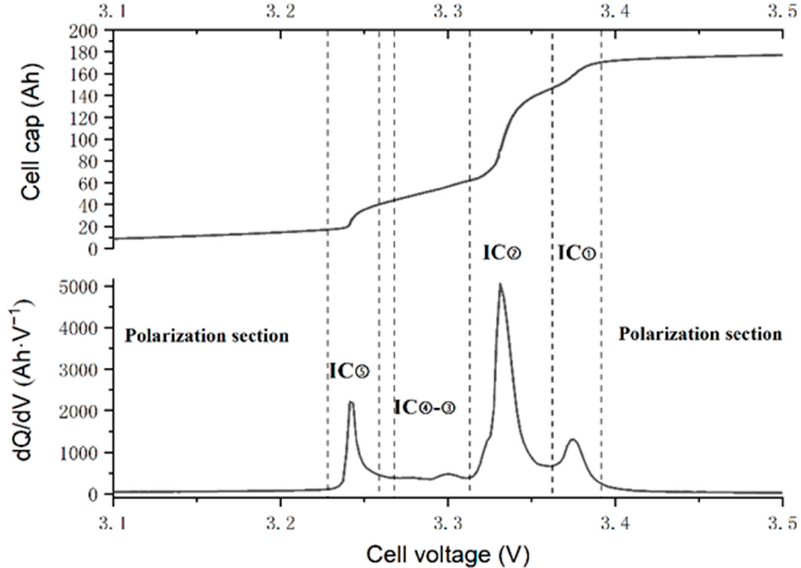
Figure 3. IC curve and V − Q curve of LiFePO4 battery.